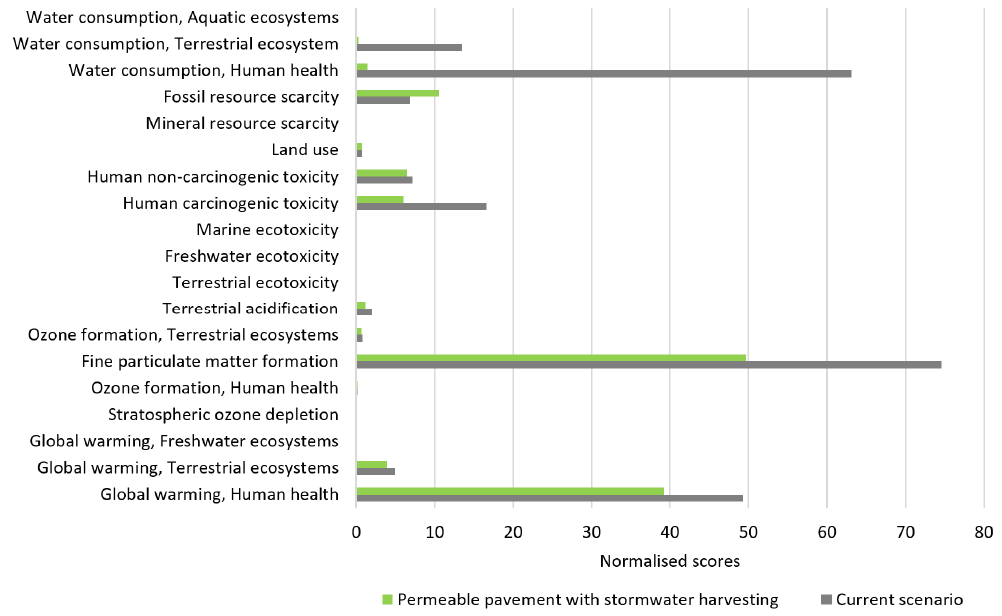
Figure 4. Comparison of scenarios using the ReCiPe endpoint method (normalised data).